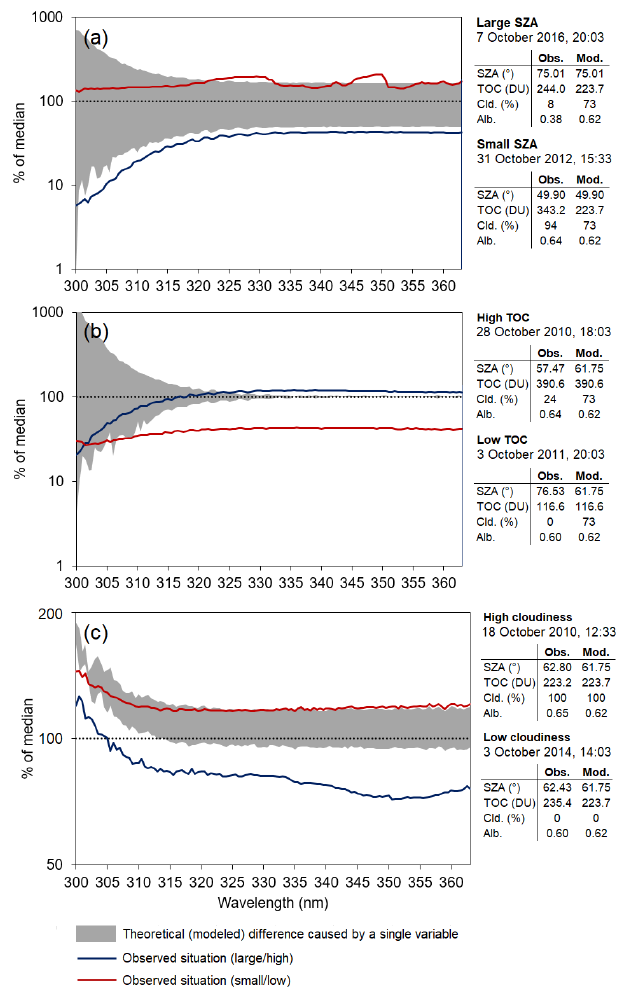
Figure 10. Spectral UV irradiance relative to the monthly median on eight selected October days, and the potential impact of se- lected variables (grey area) with extremely large/high or small/low (a) SZA, (b) TOC, and (c) cloud cover at Marambio Base in